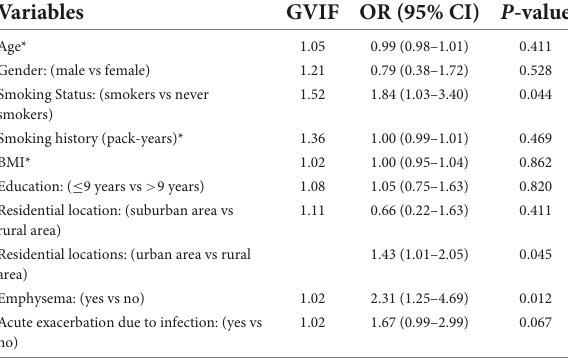
TABLE 5 A multivariable logistic regression analysis of risk factors for recurrent acute